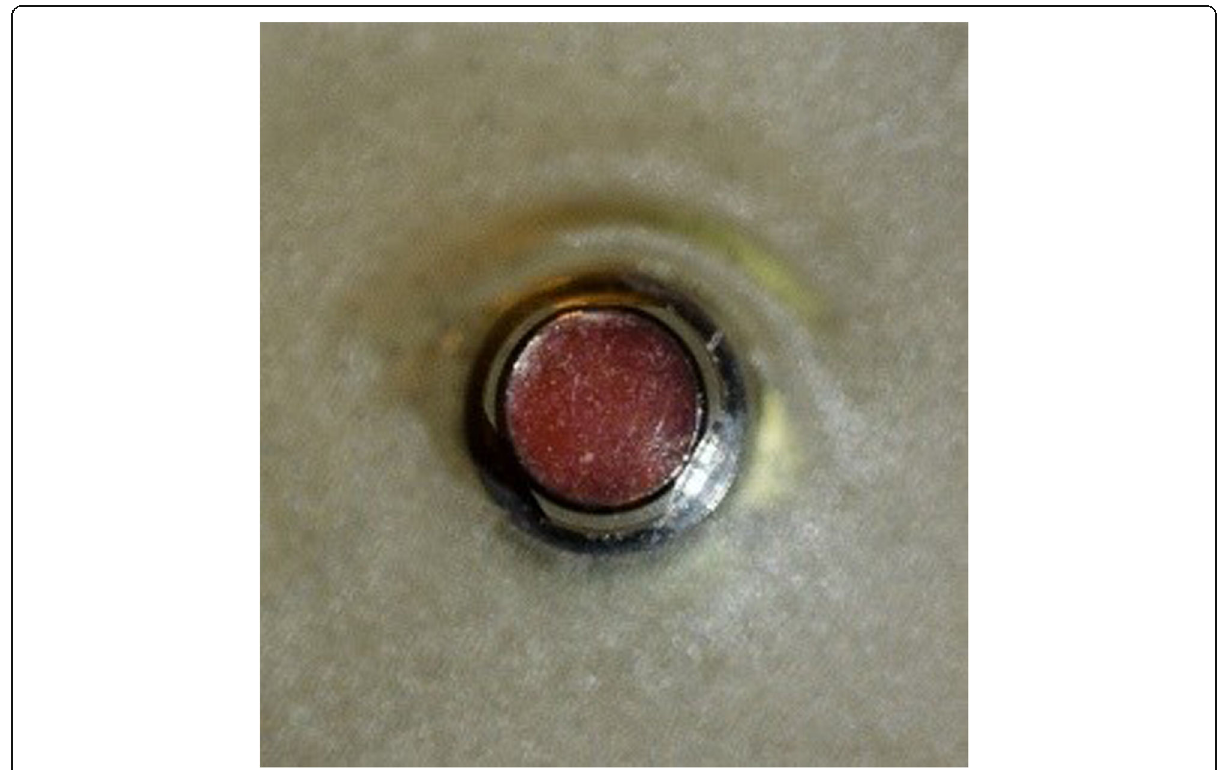
Fig. 2 Top view of the abutment with rotation